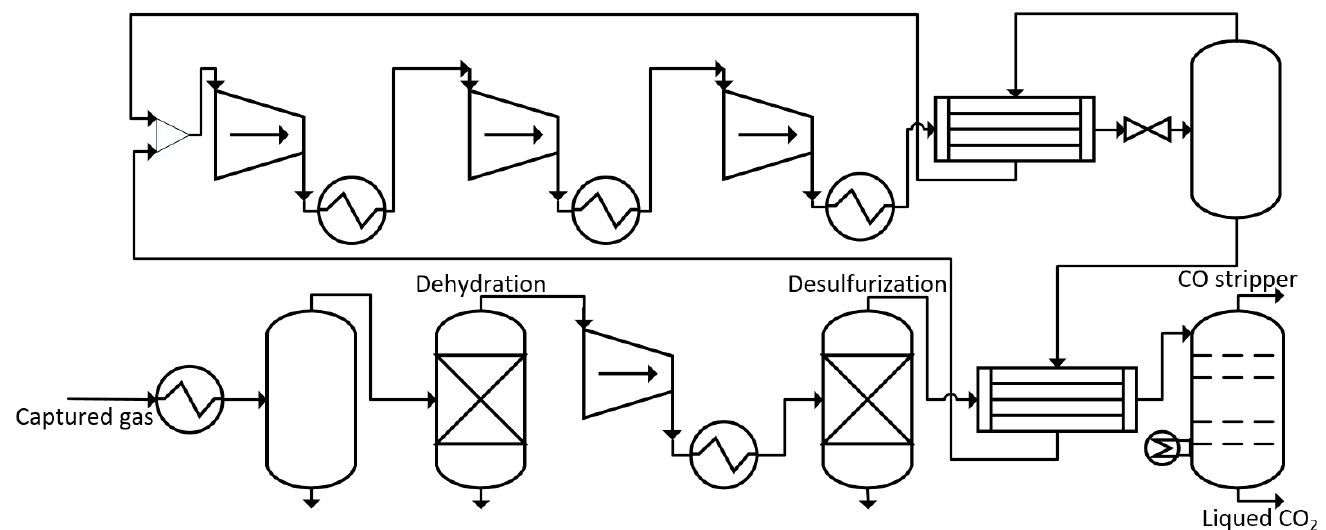
Figure 13. Process flow diagram for the closed-cycle configuration 2. Table 8. Results for the closed-cycle configuration